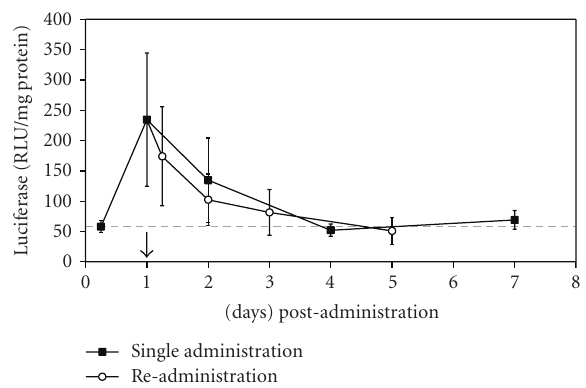
Figure 7: Luciferase expression (RLU/mg protein) in the trachea and lung of BALB/c mice following the administration of D- SPM/pDNA at ratio 16, containing 13.5 μ g pDNA with succeeding readministration post 24h of first dosing. The vertical arrow pointing downward indicates the time point of readministration after the initial administration. The horizontal dash line represents the approximate sensitivity of the assay. Data are presented as mean ± S.E.M from 6